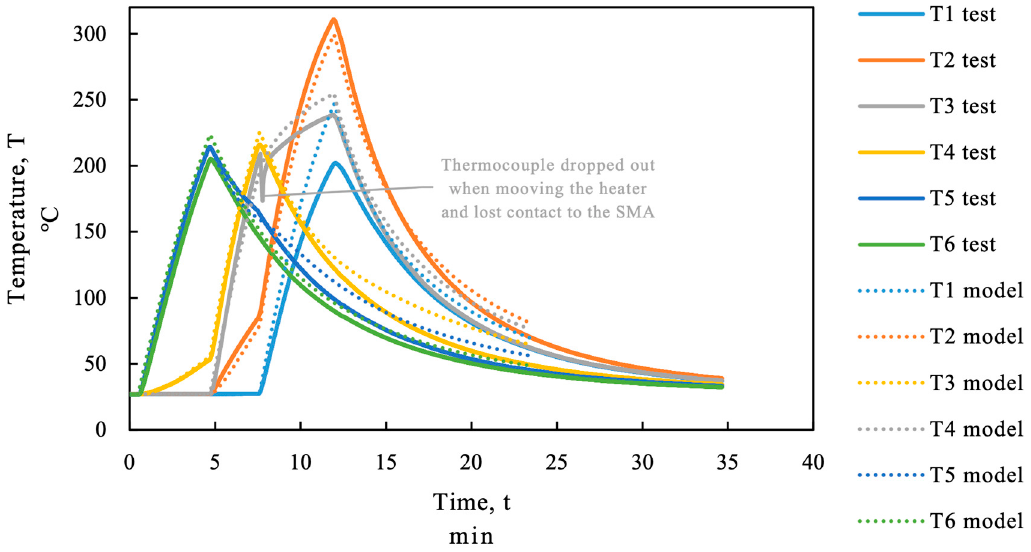
Figure 15. Comparison of the measured temperature and the modeled temperature; beam SMA_1.